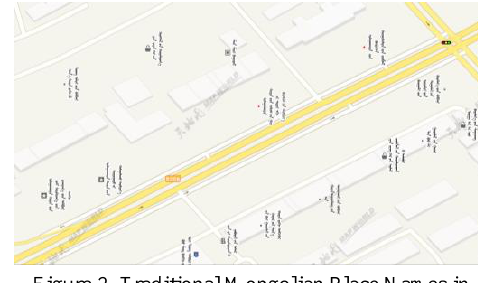
Figure 2. Traditional Mongolian Place Names in Chifen City, China